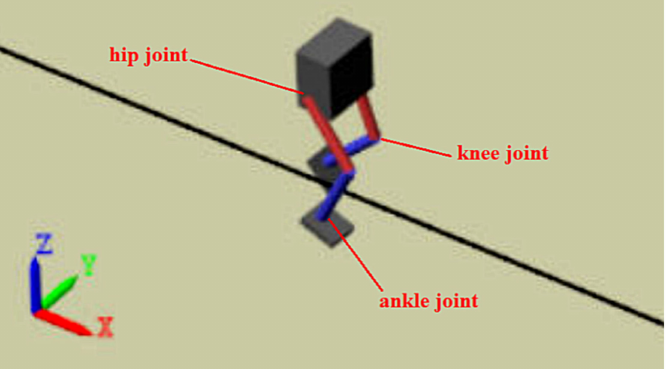
Figure 3. Simulation environment. The robot’s body and ground can be regarded as the environment. The motor at the three joints (ankle, knee and hip) of each leg can be regarded as the agent. Our task is to make the motor output an appropriate torque to control the robot to walk along a straight line.